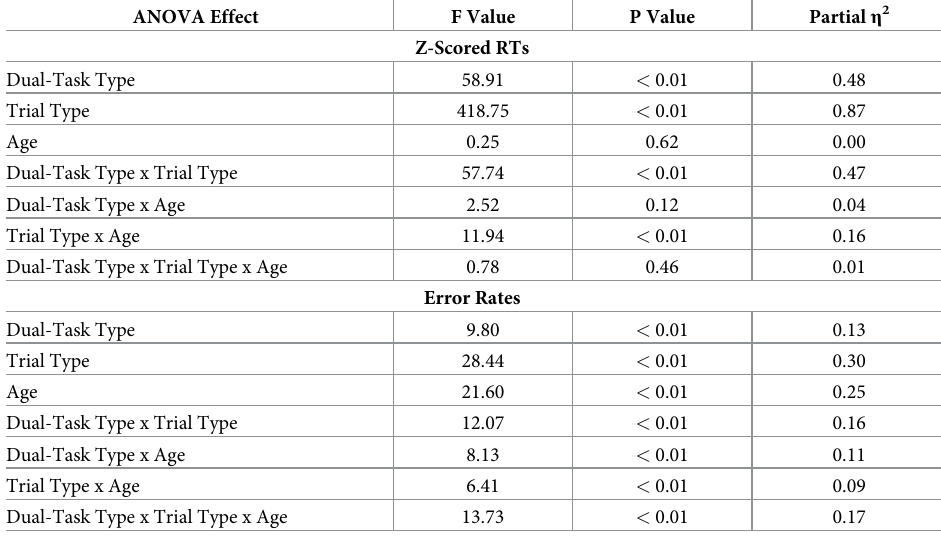
Table 4. Dual-task inferential statistics for primary task response latency and